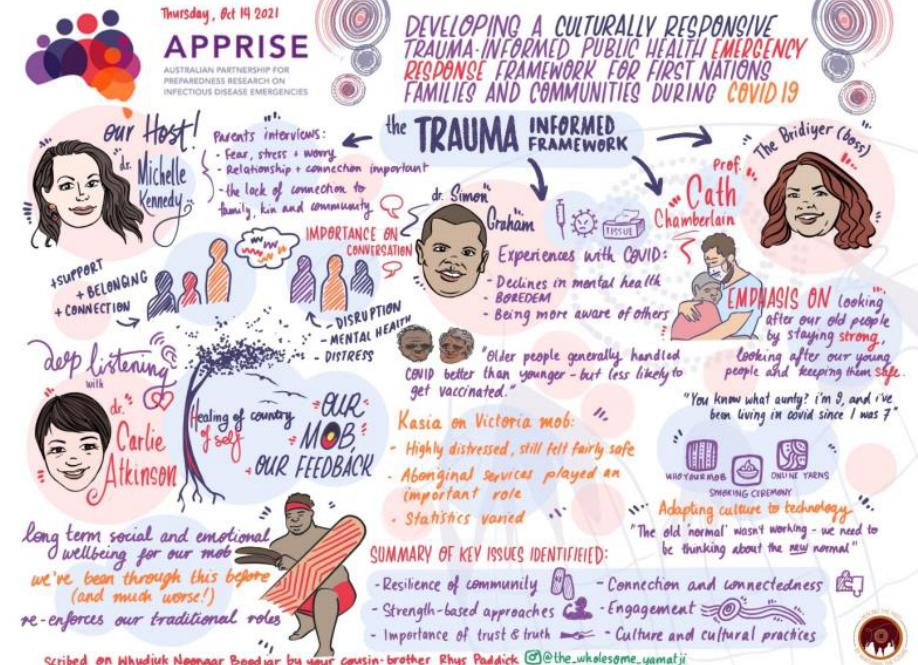
Figure 1. Graphic design of the trauma-informed workshop.